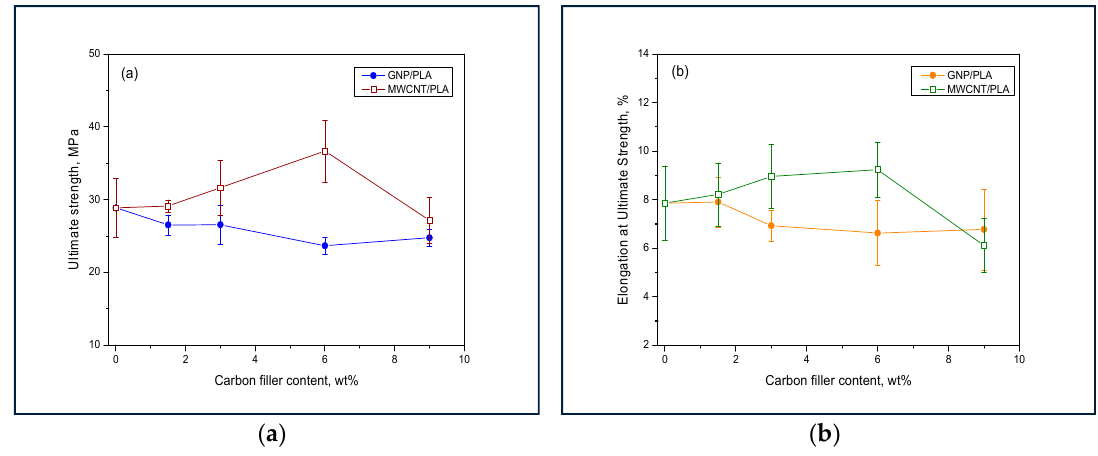
Figure 8. Tensile strength ( a ) and elongation at ultimate strength ( b ) vs. carbon filler content for MWCNT/PLA and GNP/PLA nanocomposites.